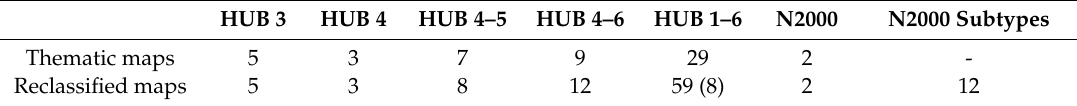
Table 6. Number of unique classes found in the reclassified thematic maps versus the thematic maps (same number of classes as in the training data). Number of classes with less than 10 predicted pixels are put in brackets (full list of classes and pixel count for HUB 1–6 available in Supplementary Materials Table S3).